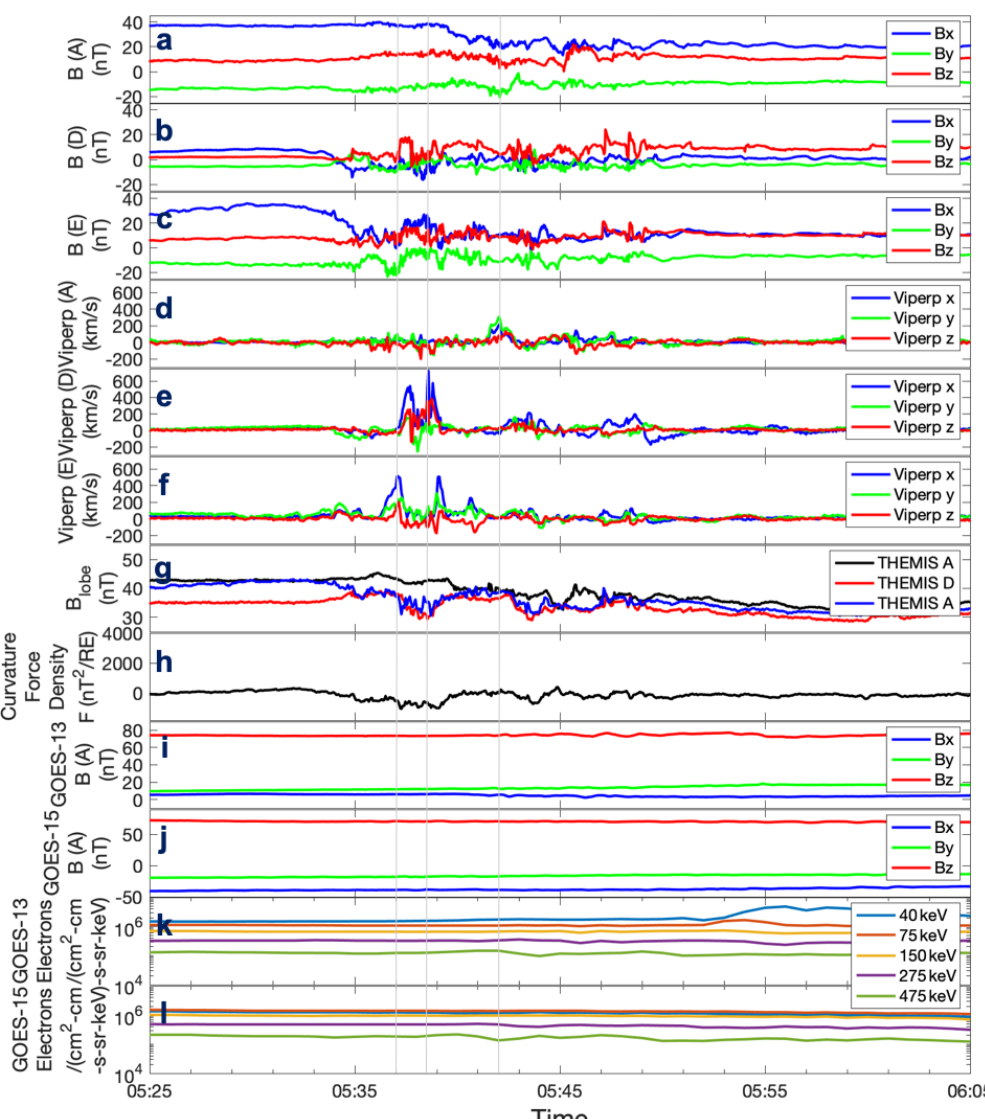
Figure 7. THEMIS spacecraft in situ measurements for pseudobreakup Case 1 on 25 December 2015. (a–c) The magnetic field measured by THEMIS A, D and E, respectively, (d–f) the perpendicular ion velocity measured by THEMIS A, D and E, respectively, (g) the magnetic lobe ( B lobe ), (h) the curvature force density ( F ), (i,j) the magnetic field from GOES 13 and GOES 15, respectively, (k) electron flux measured by GOES 13 and (l) electron flux measured by GOES 15. The grey vertical lines mark the location of peak perpendicular ion velocity observed by each satellite associated with the fast flow